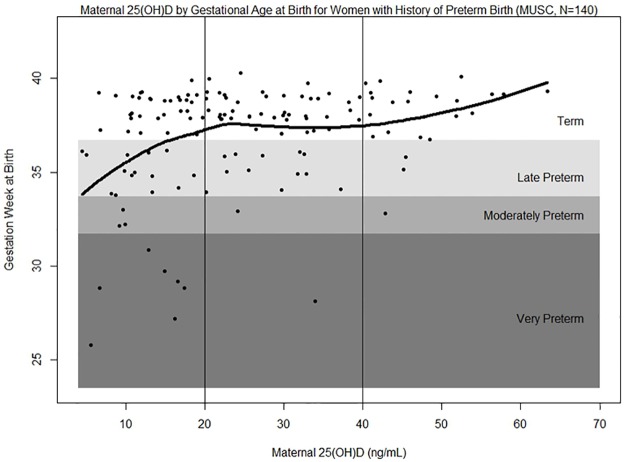
Maternal 25(OH)D concentration by gestational age (weeks) at birth for women with a prior preterm birth.Term birth is ≥37 weeks of gestation, late preterm birth is 34 to <37 weeks, moderately preterm is 32 to <34 weeks, and very preterm is <32 weeks. Black line represents fitted LOESS curve.